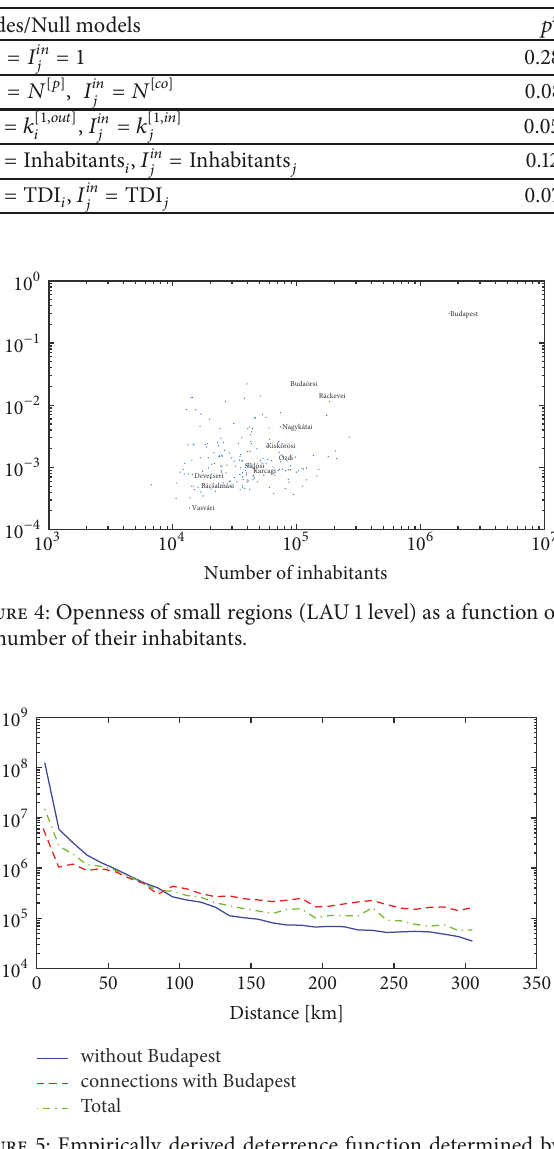
Table 2: Performances of distance-dependent null models.